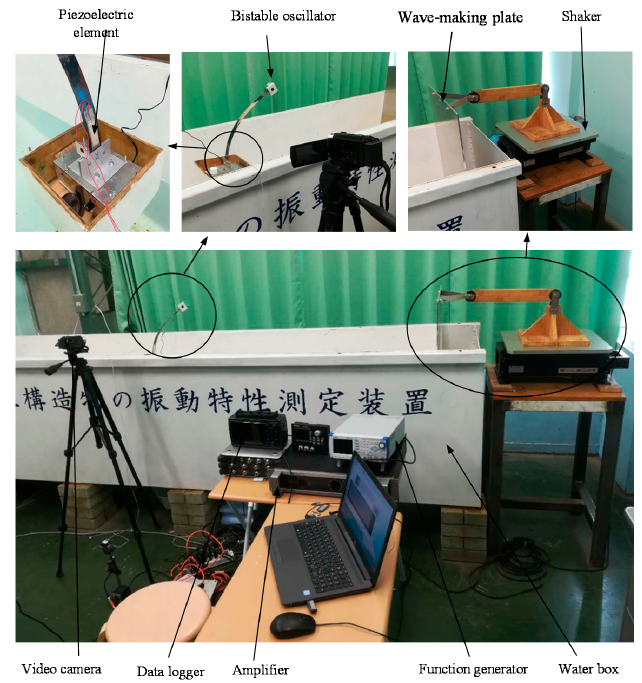
Figure 2. The experimental equipment and measurement system for bistable vibration power gen- eration system in random wave environment. generation system in random wave